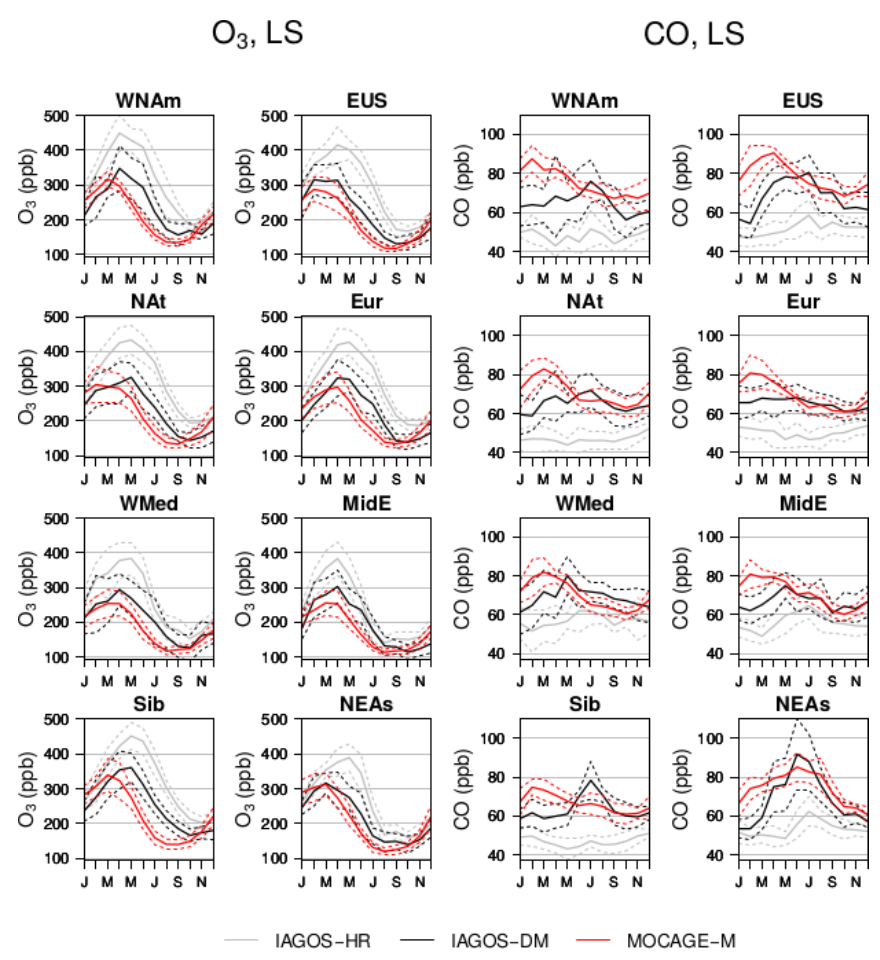
Figure C2. As Fig. C1 for the